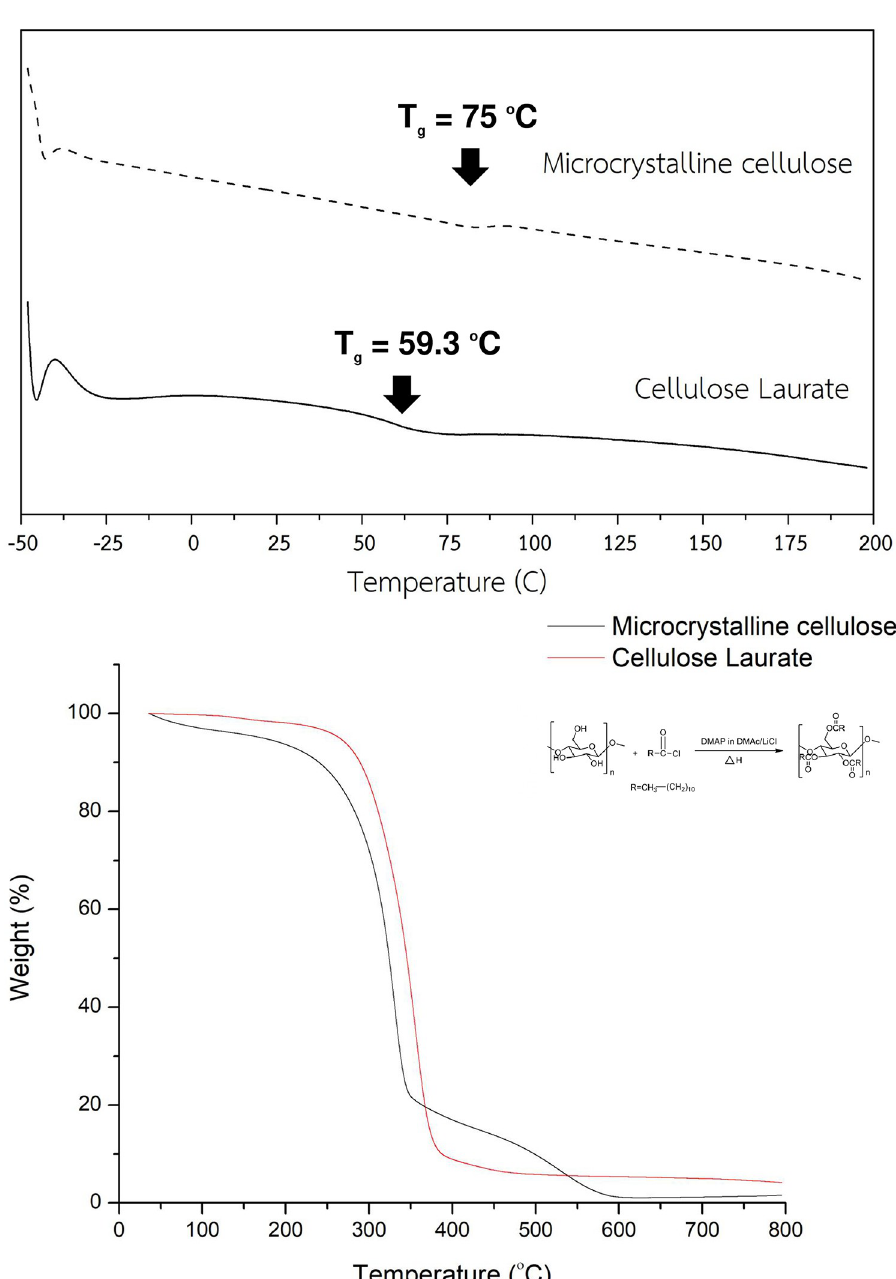
Fig 6. DSC thermograms (A) of native PALF-MCC and esterified PALF-MCC laurate and TGA thermograms (B) of native PALF-MCC and esterified PALF-MCC